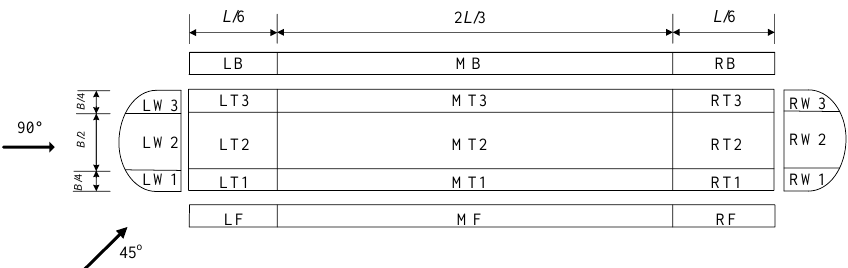
Figure 11. Zoning diagram of wind pressure coefficient with 45° and 90° azimuth angles.